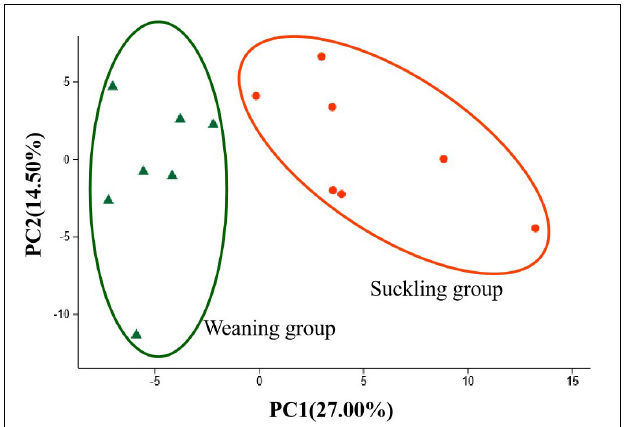
FIGURE 5 | PCA score plots of metabolies in colonic digesta of piglets between the suckling group and the weaning group. Orange dots represent the suckling piglets, green triangles represent the weaned piglets, N =